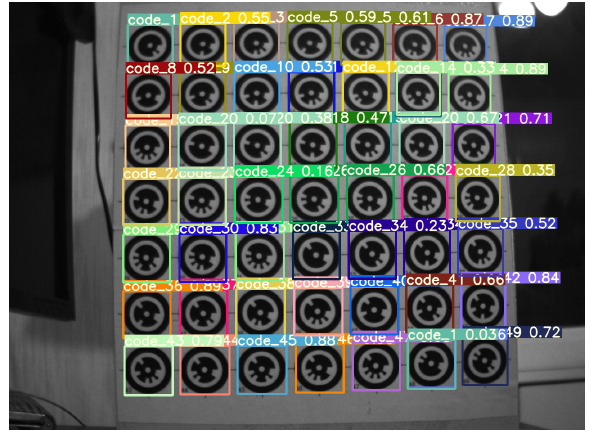
Figure 1. Example results of coded targets detection by our YOLO-Target